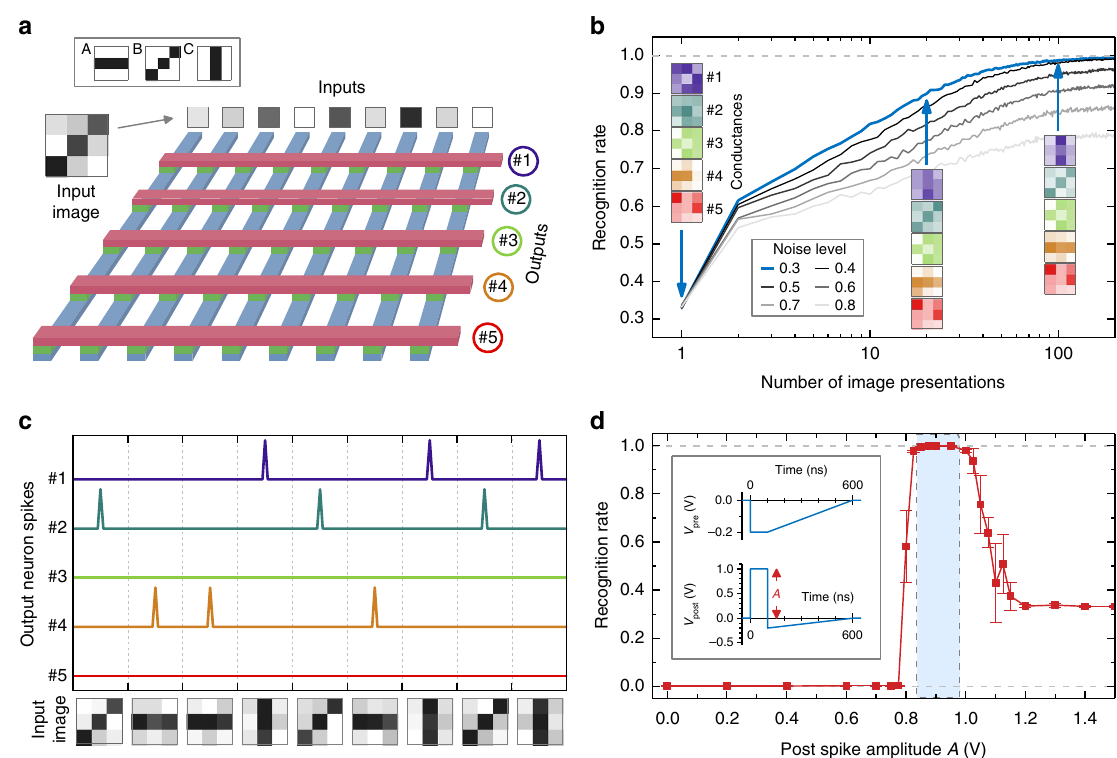
Figure 4 | Unsupervised learning with ferroelectric synapses. ( a ) Simulated spiking neural network comprising nine input neurons connected to five output neurons by an array of ferroelectric memristors. The inputs are noisy images of the patterns to recognize: horizontal (A), diagonal (B) and vertical (C) bars in 3 (cid:3) 3 pixel images. ( b ) Recognition rate as a function of the number of presented images for different noise levels. The coloured images are conductance maps of the memristors in each line and show their evolution for a noise level of 0.3 (blue line). ( c ) Behaviour of the network after successful learning. Neurons 1, 2 and 4 emit spikes when inputs C, B and A are presented, respectively. ( d ) Evolution of the final recognition rate as a function of the amplitude of the post-synaptic spike. Error bars represent